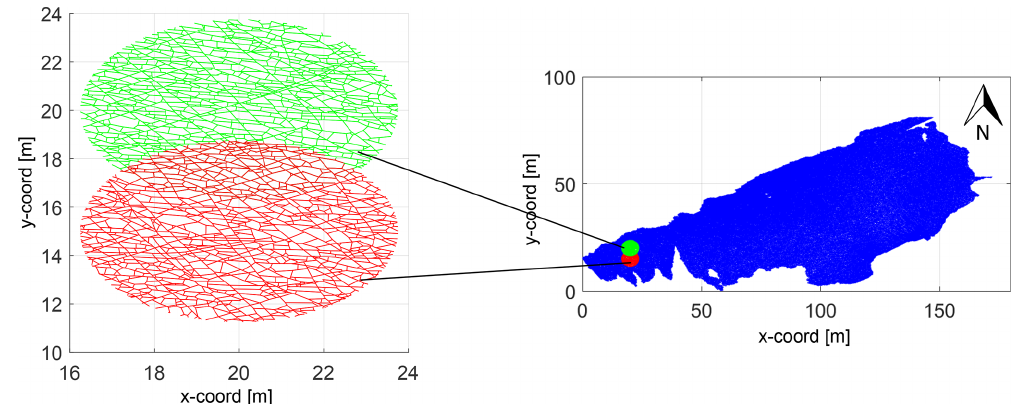
Figure 8. Subsampling of a fracture graph corresponding to full region into subgraphs of 7.5m diameter and spacing of